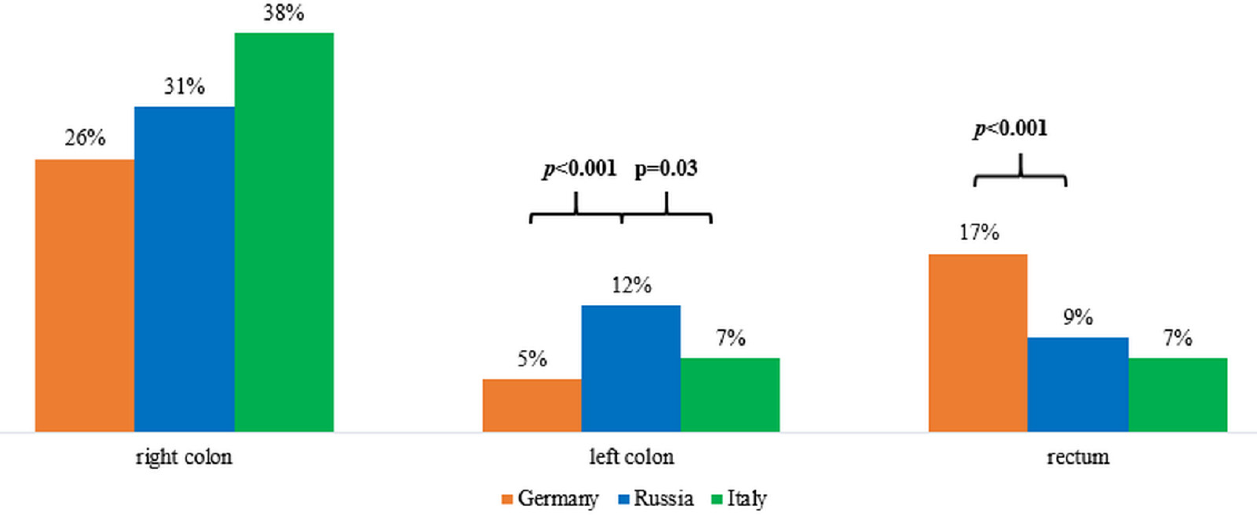
Figure 6. Frequency of MSI in the right colon, left colon, and rectum in Germany, Russia, and Italy.